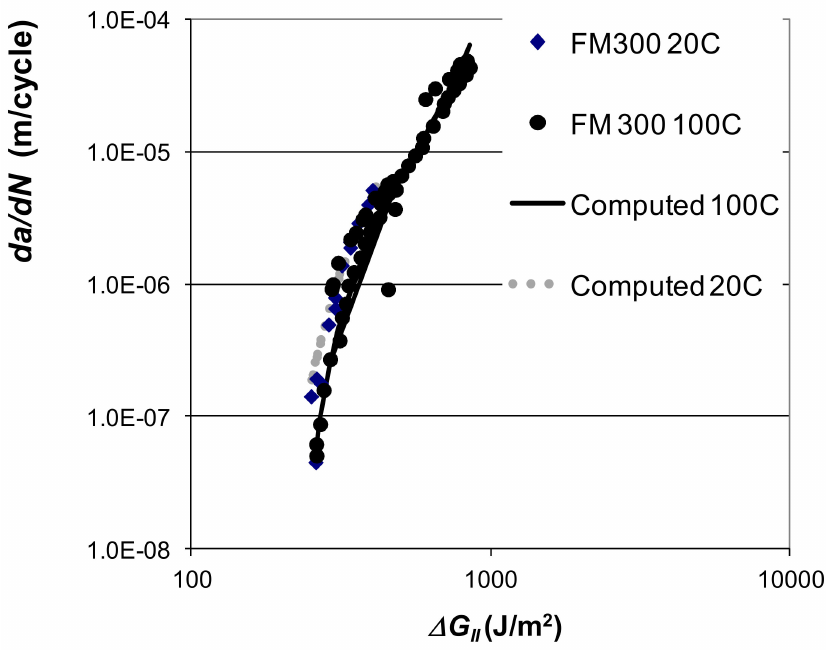
Figure 4. The measured [72] and computed [60] R = − 1 da / dN versus ∆ G II curves for